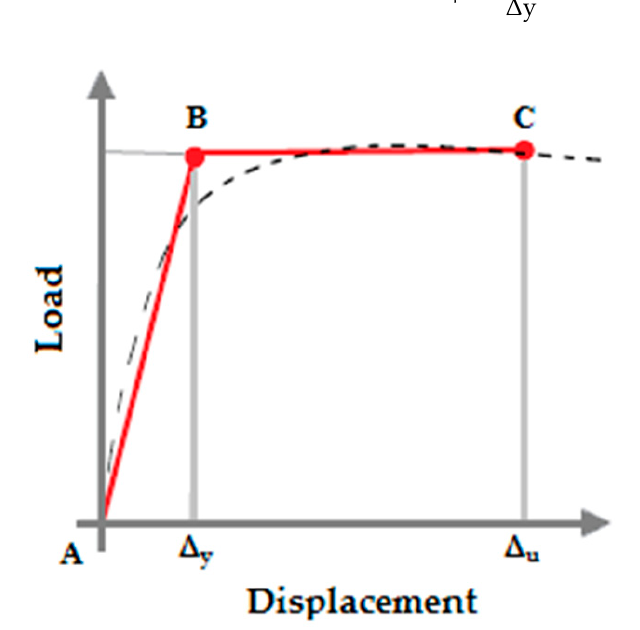
Figure 10. Idealization of the load–displacement curve with an equivalent bilinear diagram.